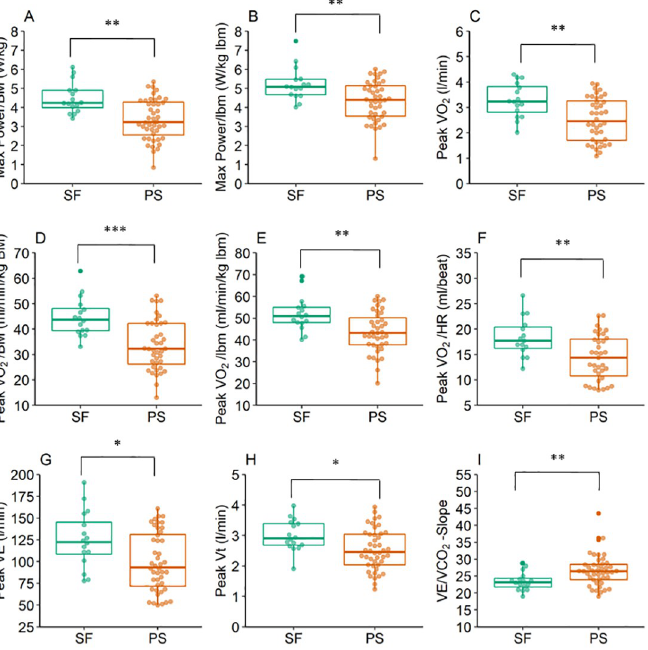
(dif = 16.86%, p = 0.008, d = 0.347), Peak VO (dif = 23.17%, p = 0.004, d = 0.385), Peak VO 2 BM (dif = 24.63%, p < 0.001, d = 0.476), Peak VO /lbm (dif = 16.32%, p = 0.005, d = 0.375) 2 (Peak VO /HR (dif = 21.53%, p = 0.009, d = 0.371), Peak VE (dif = 20.43%, p = 0.021, 2 d = 0.299) and VE/VCO -Slope (dif = -13.77%, p = 0.008, d = 0.340). When considering time 2 since infection as a confounder, a tendency was observed for the variable Peak Vt (p = 0.082). Without consideration of any confounder (dif = 15.67%, p = 0.010, d = 0.331) or with consid- eration of age (p = 0.012) there was a significant difference, respectively. Even with consider- ation of time since infection or age, no differences were found for Peak HR, Peak Bf, and Peak Vt/VC.